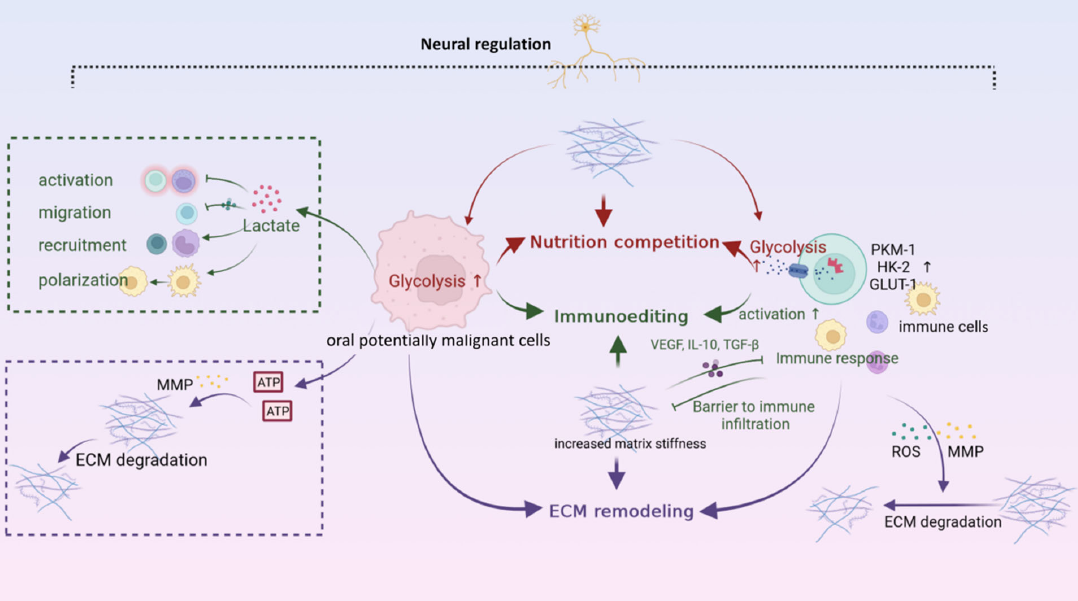
Figure 5. The immuno–metabolic–mechanical–neural interaction network affects carcinogenesis of OPMDs profoundly. The metabolic activities of potentially malignant cells negatively affect the immune microenvironment and remodel ECM. While the immune cells upregulate glycolysis and are activated to perform nutrition competition, immunoediting, and ECM remodeling against potentially malignant cells. Meanwhile, ECM undergoes remodeling to adapt to the changes of microenvironments. Pointed arrows mean “promote” and blunt ‐ end arrows mean “inhibit”. The upward arrows “ ↑ ” indicate “increase”. ROS, reactive oxygen species; MMP, matrix metalloproteinase; ECM, extracellular matrix.